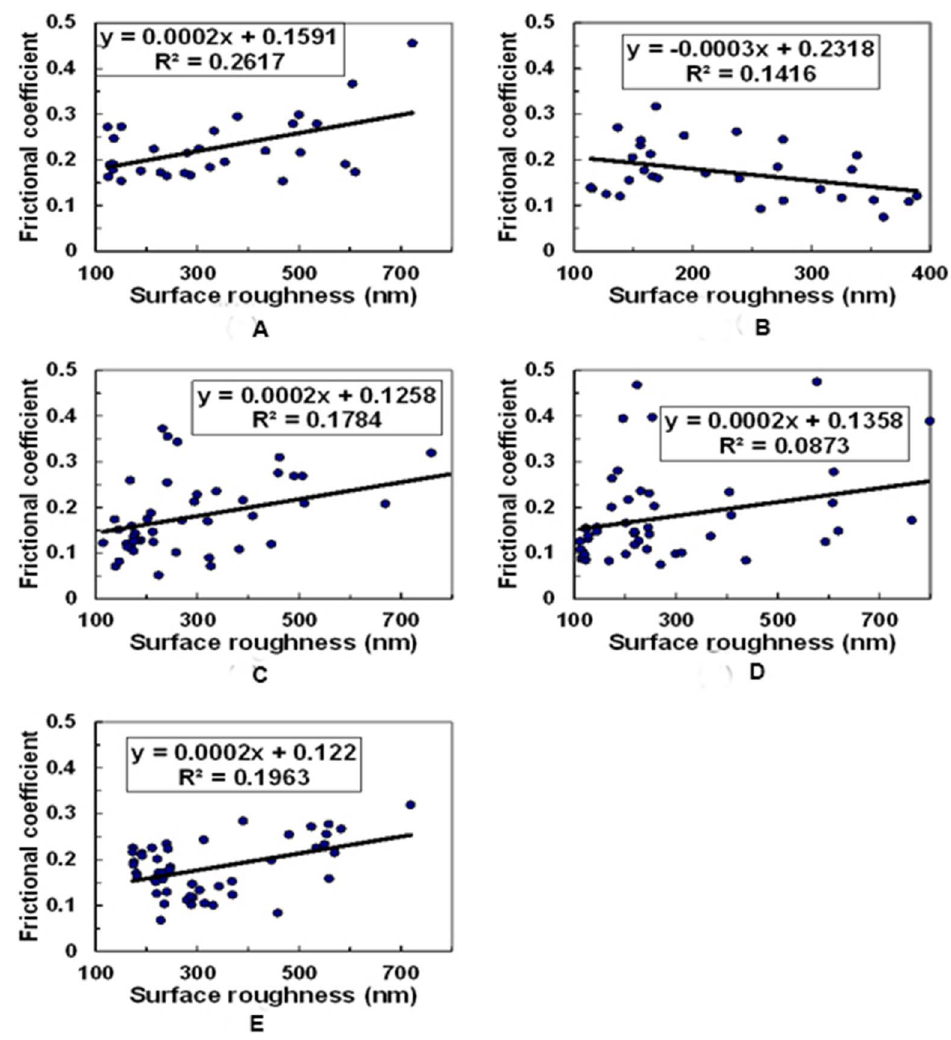
Figure 10. The correlations between surface roughness (R q ) and frictional coefficient ( m ) for (A) 0.5 mg c -Globulin (n 5 30), (B) 2 mg c -Globulin (n 5 30), (C) 1 mg HA (n 5 48), (D) 3 mg HA (n 5 48), and (E) 5 mg HA (n 5